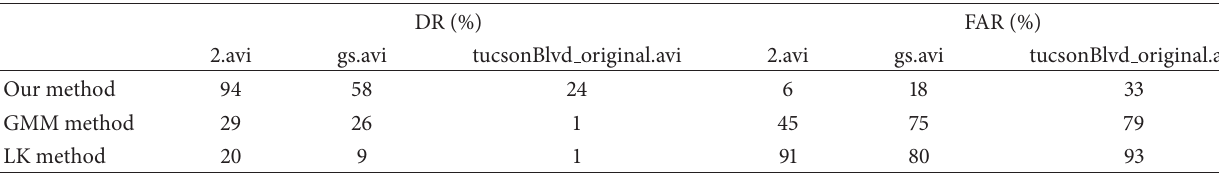
Table 2: Quantitative analysis of detection with other methods.